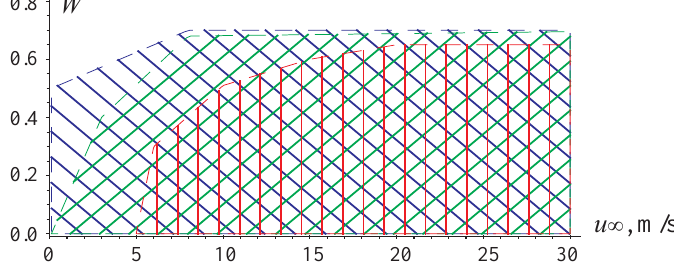
Figure 6. Regions of steady fire propagation at several typical CFM layer density val- ues. Results are received at ρ 0 : 0.1 kg/m 3 —shown as vertical lines, 0.2 kg/m 3 —plus 45 inclination, 0.4 kg/m 3 —minus 45